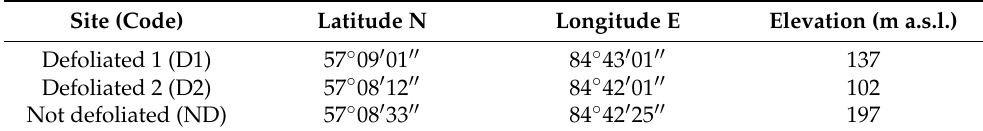
Table 1. Sites’ geographical features including latitude, longitude and elevation.